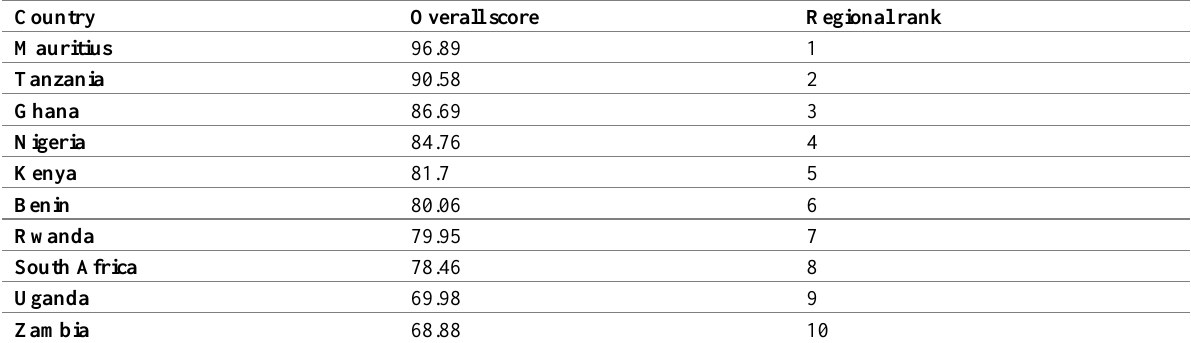
Table 5: Top 10 African countries in Global Cybersecurity Index